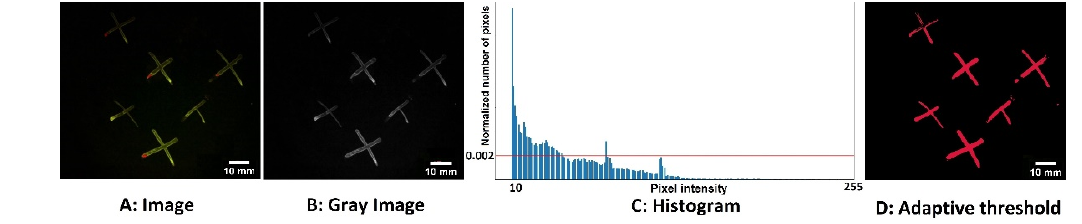
Figure 2. The adaptive threshold segmentation method used to detect fluorescence emission areas from olive oil residue marks. ( A ) The fluorescence image from the color camera; ( B ) the extracted green band monochrome image; ( C ) the histogram and threshold (red line); and ( D ) the resulting binary image mask. The scale bar for all images is set to 10 mm.